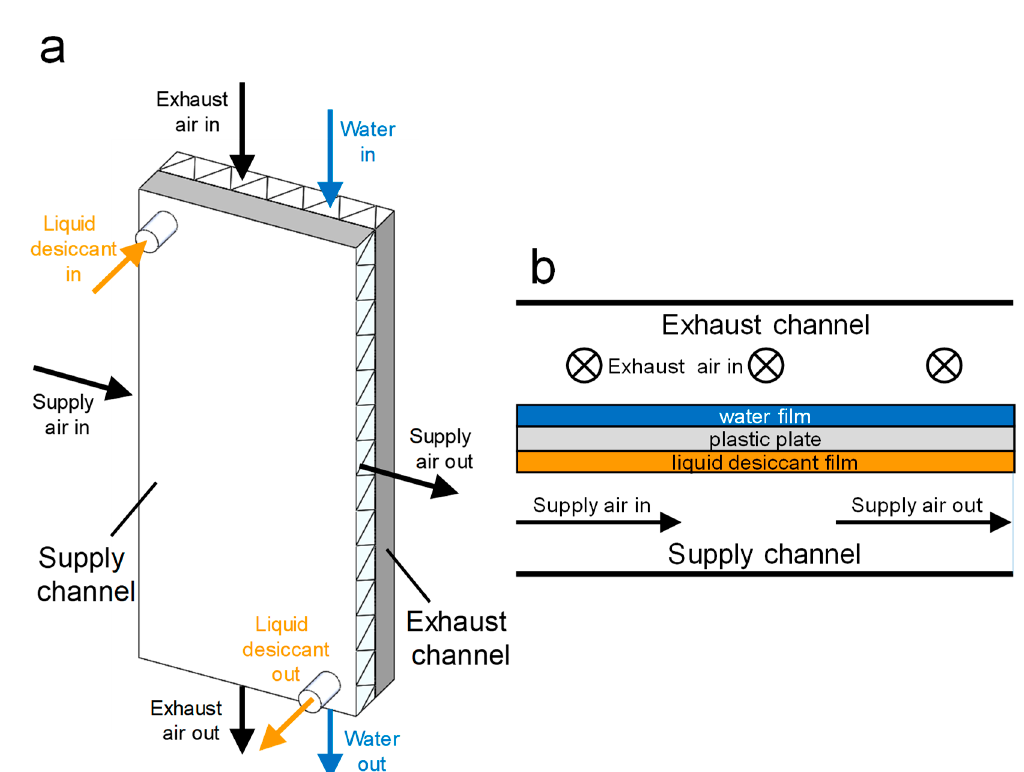
Figure 1. Schematic of a pair of supply and exhaust channels of an internally-cooled liquid desiccant dehumidifier: ( a ) isometric view; ( b ) top view. Table 1. Specifications of the dehumidifier.